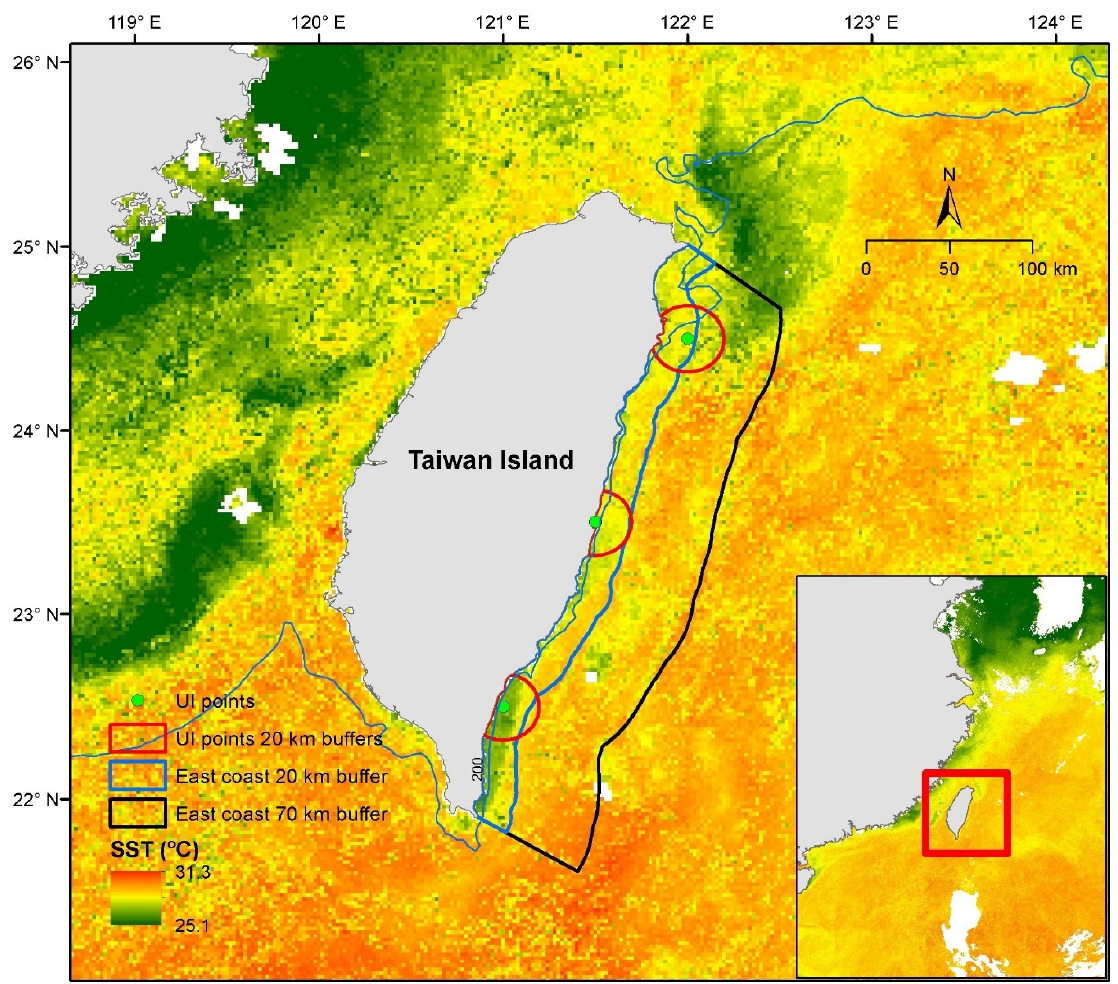
Figure 1. The study area is the coastal area of eastern Taiwan Island; the thick blue and black lines indicate the 20 km and 70 km buffers from the east coast of Taiwan; the green dots indicate the locations where the upwelling index (UI) was calculated using the CFS wind data; the red lines indicate the 20 km buffer around the UI points; the thin blue line is the 200 m isobath representing the approximate boundary of the continental shelf. The background image is the H-8 SST image on 19 July 2016.